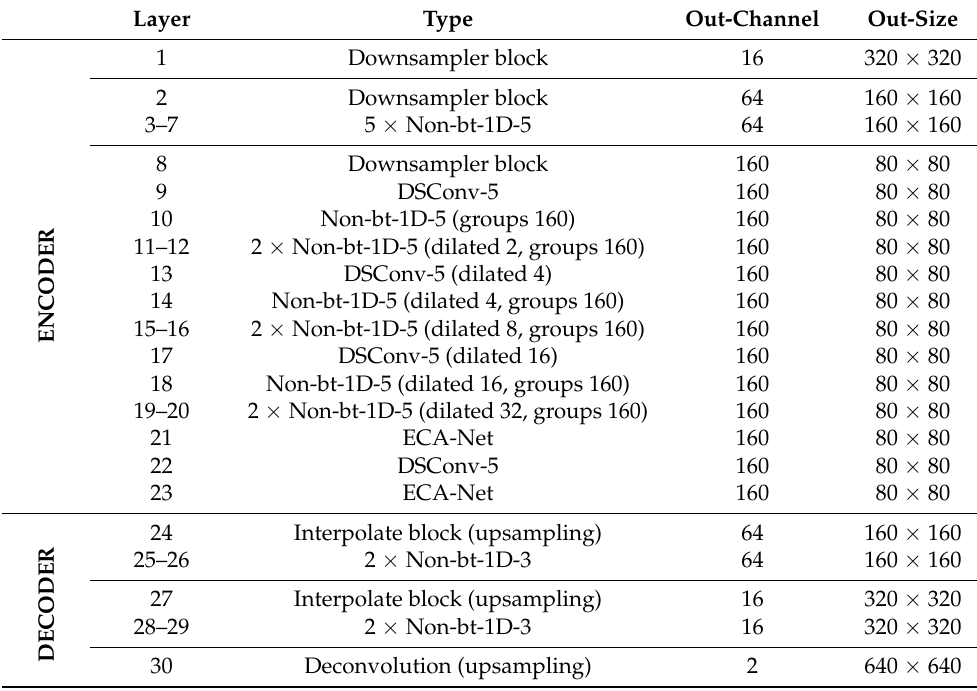
Table 3. Network model